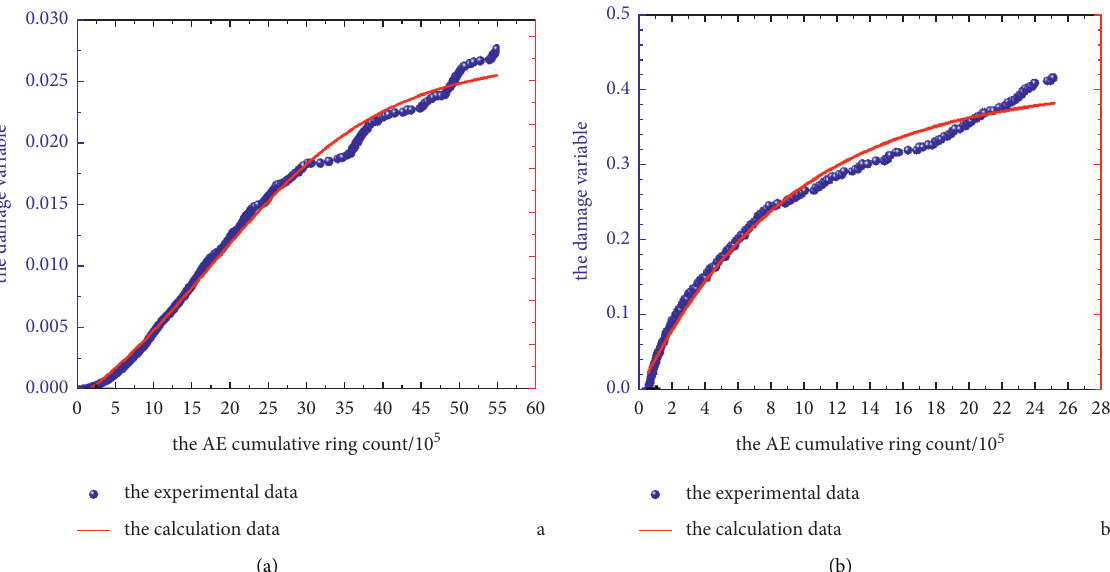
Figure 9: Comparison of test results and model results between cumulative ringing count N and damage variable D . (a) V1-1 and (b)